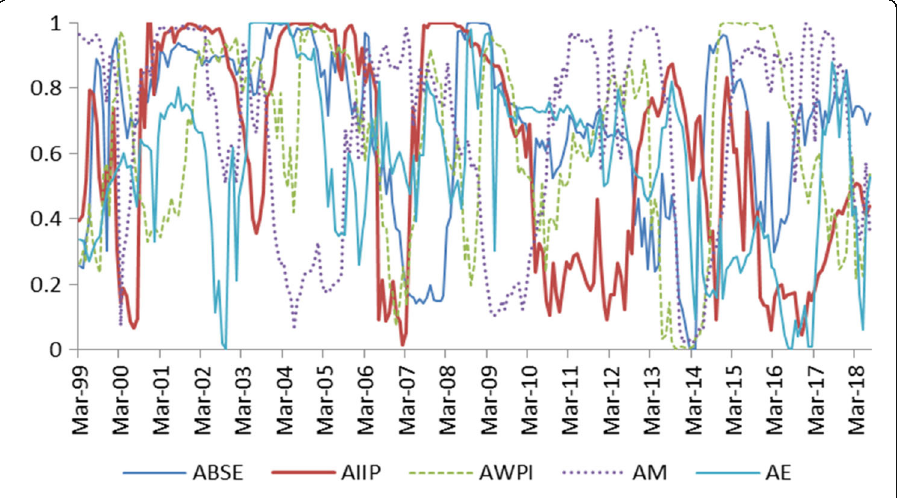
Fig. 6 Rolling Unit Root Test for ACE Transformed